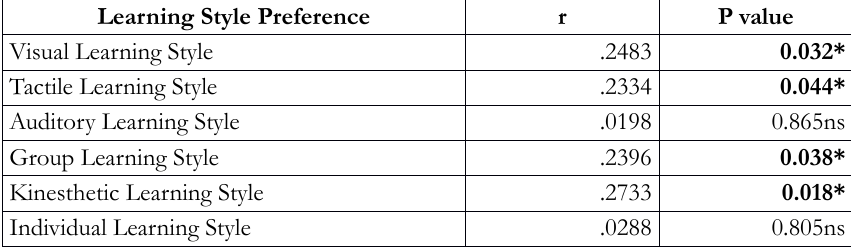
Table 7. Correlation between Academic Achievement and Learning Style